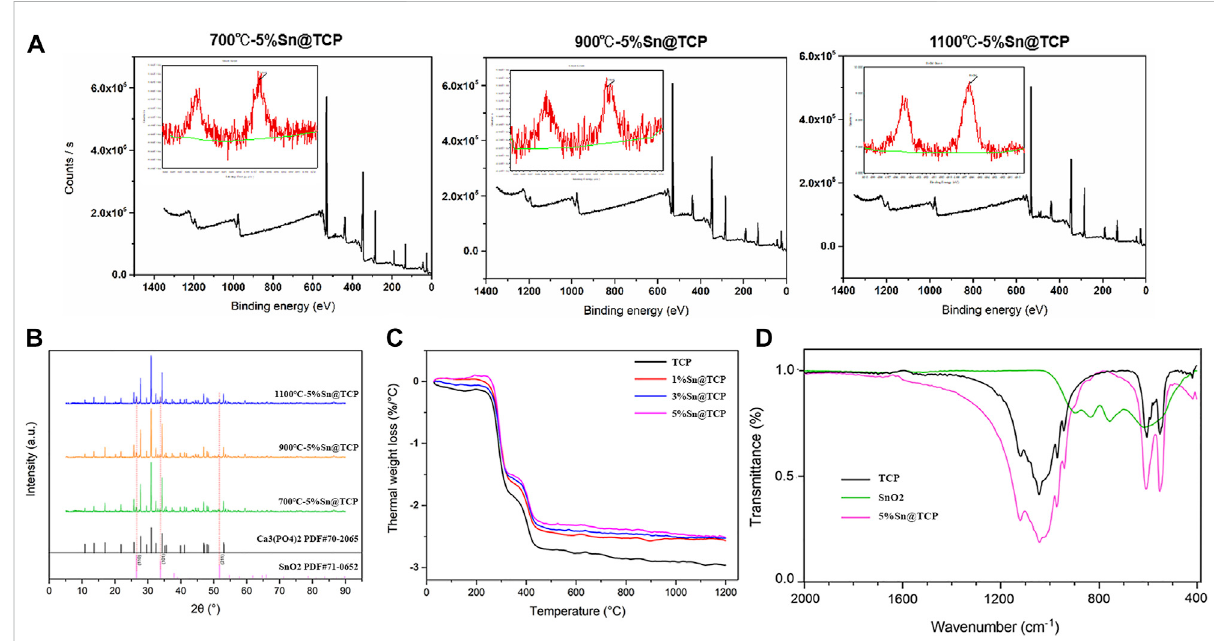
FIGURE 3 CharacterizationofTCPpowderswithdifferentSndoping. (A) XPSspectraof5%Sn@TCPwithdifferentsinteringtemperature(700 ° C,900 °